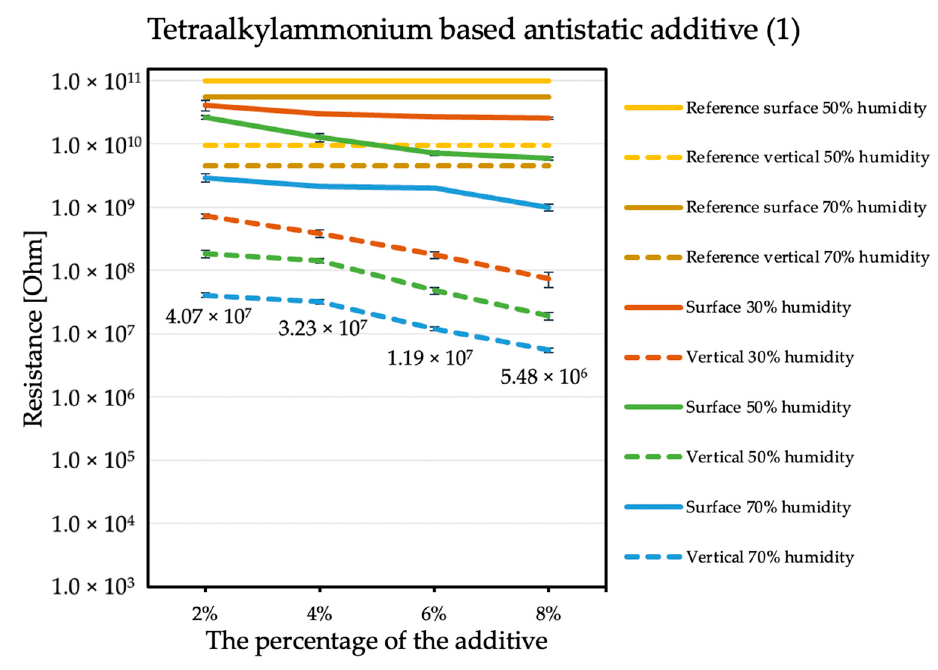
Figure 1 . Resistances of coatings with tetraalkylammonium based antistatic additive .